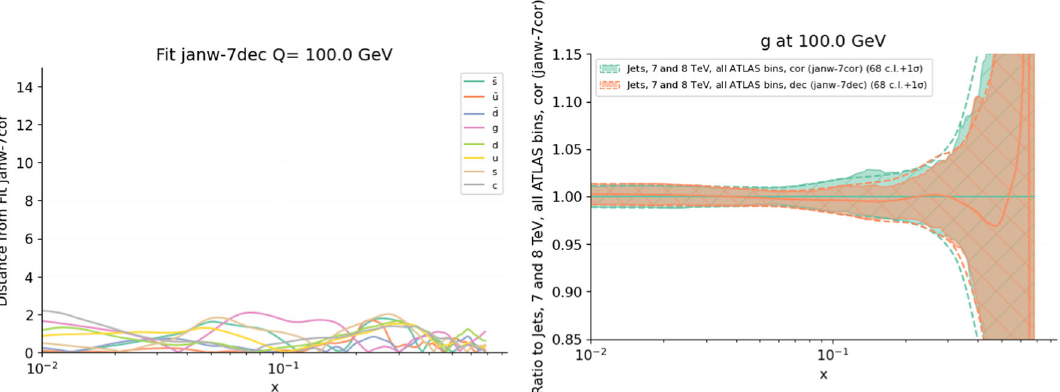
Fig. 11 Same as Fig. 6, but now comparing the fits to single-inclusive jetdata(alldatasets,NNLOQCD+EW),inwhichallrapiditybinsofthe ATLAS 7 TeV data are included, either with (fit #janw-7cor) or with-